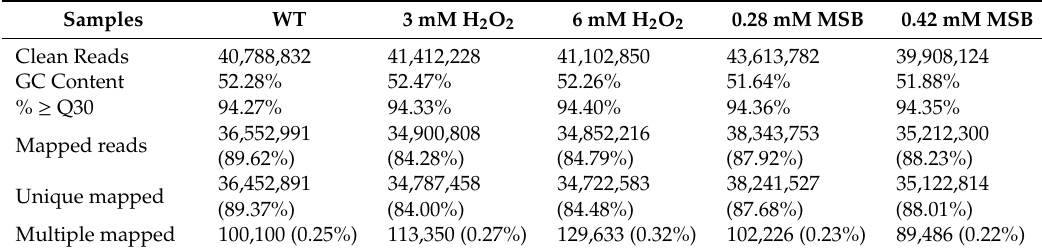
Table 1. Summary of the sequencing data and gene numbers of A. oryzae transcriptome under oxidative stress.